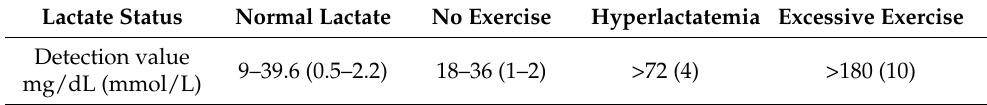
Table 1. The individual status of lactate. Lactate Status Normal